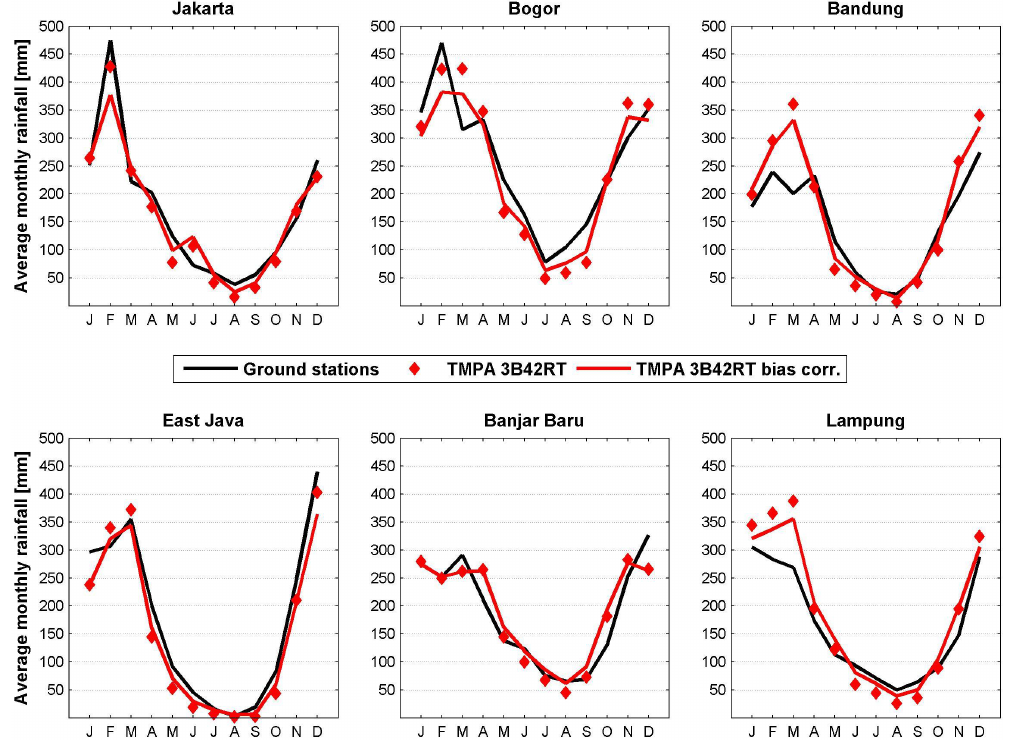
Fig. 7. Average monthly bias corrected TMPA 3B42RT data over 2003–2008, compared with ground station and uncorrected TMPA 3B42RT data. Table 5. Dry season (June–October) ground station and TMPA 3B42RT precipitation ( P , in mm per season), average difference, relative bias (%, to observations), RMSE (in mm per month) and correlation coefficients before and after bias correction of TMPA 3B42RT precipitation estimates over the period